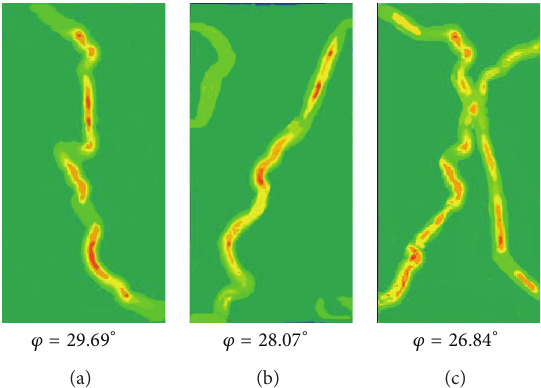
Figure 7: Contours of shear-strain rate indicating shear bands at different